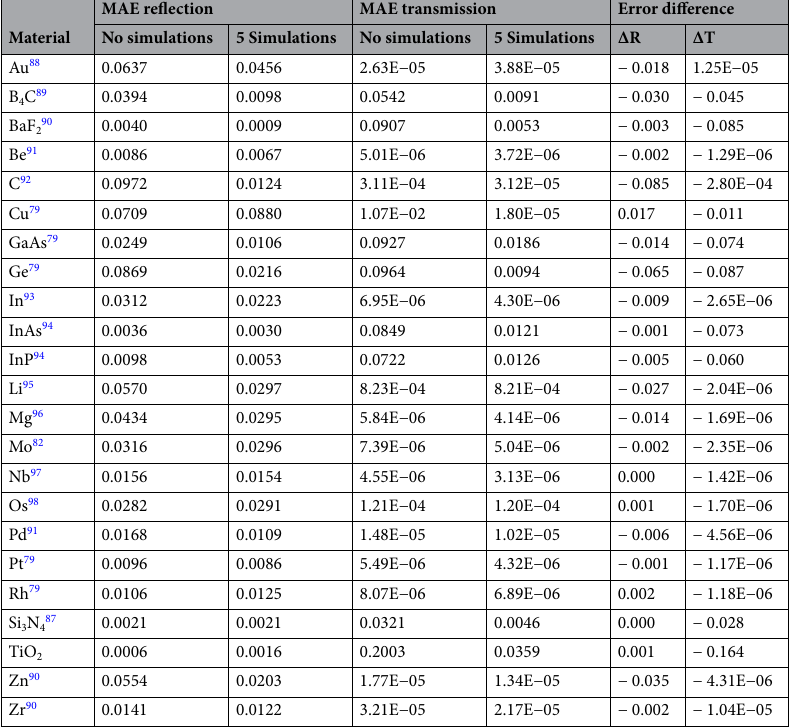
Table 1. MAE Errors in the reflection and transmission without no simulations included in the training data and 5 simulations included in training. The relative error for each material is shown, with nearly all materials showing a significant decrease in error as a result of the small amount of data being